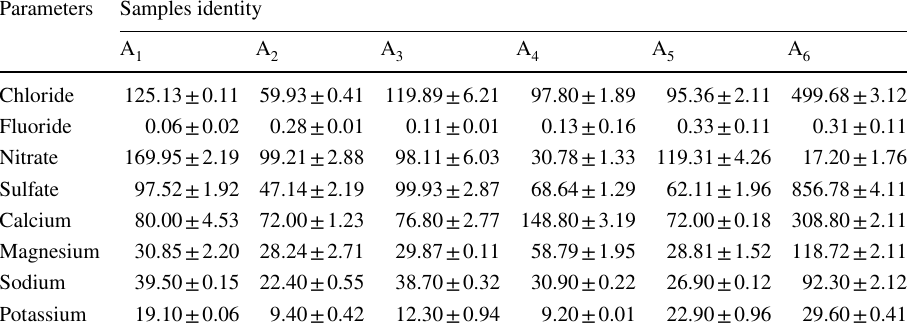
Table 2 Mean levels of some chemical characteristics of the shallow well water samples from the Angola